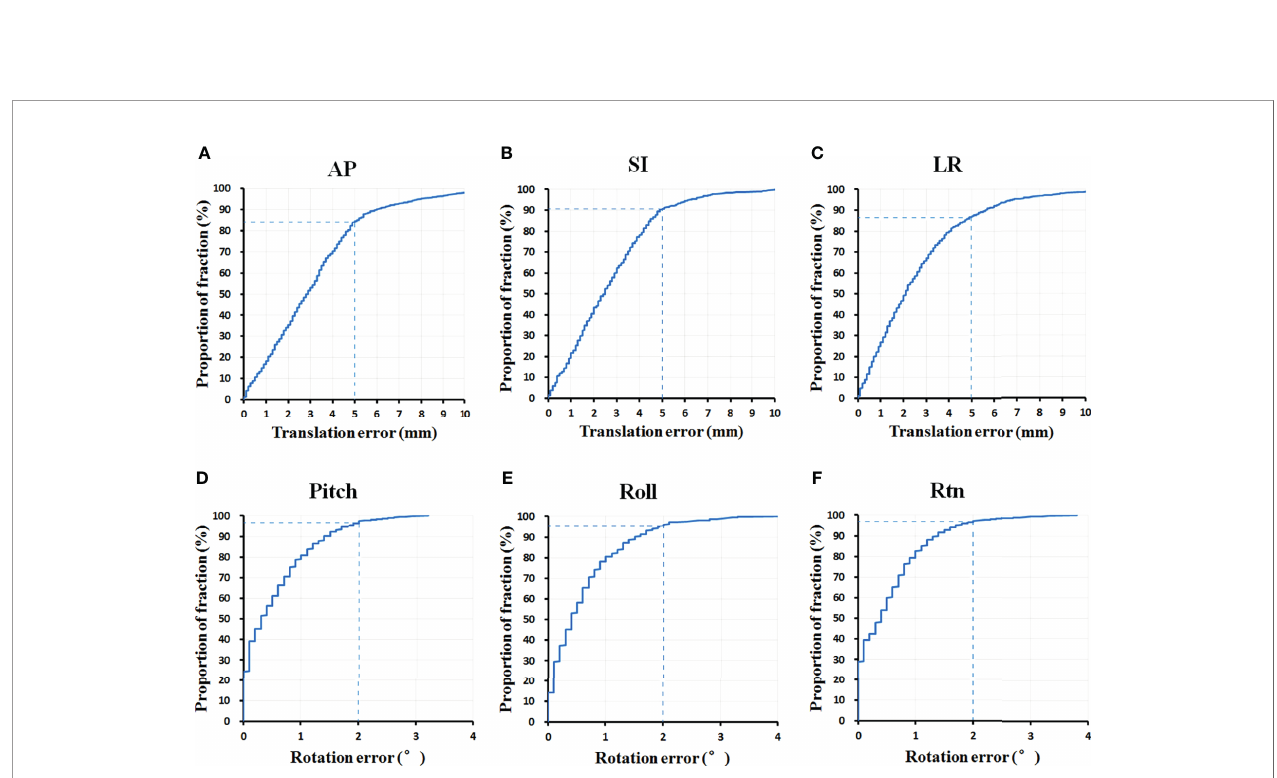
FIGURE 4 | The percentage of fractions out of setup error tolerance limits in (A) AP, (B) SI, (C) LR, (D) pitch, (E) roll and (F) rtn direction (n = 732 fractions). AP, anterior-posterior; SI, superior-inferior; LR,